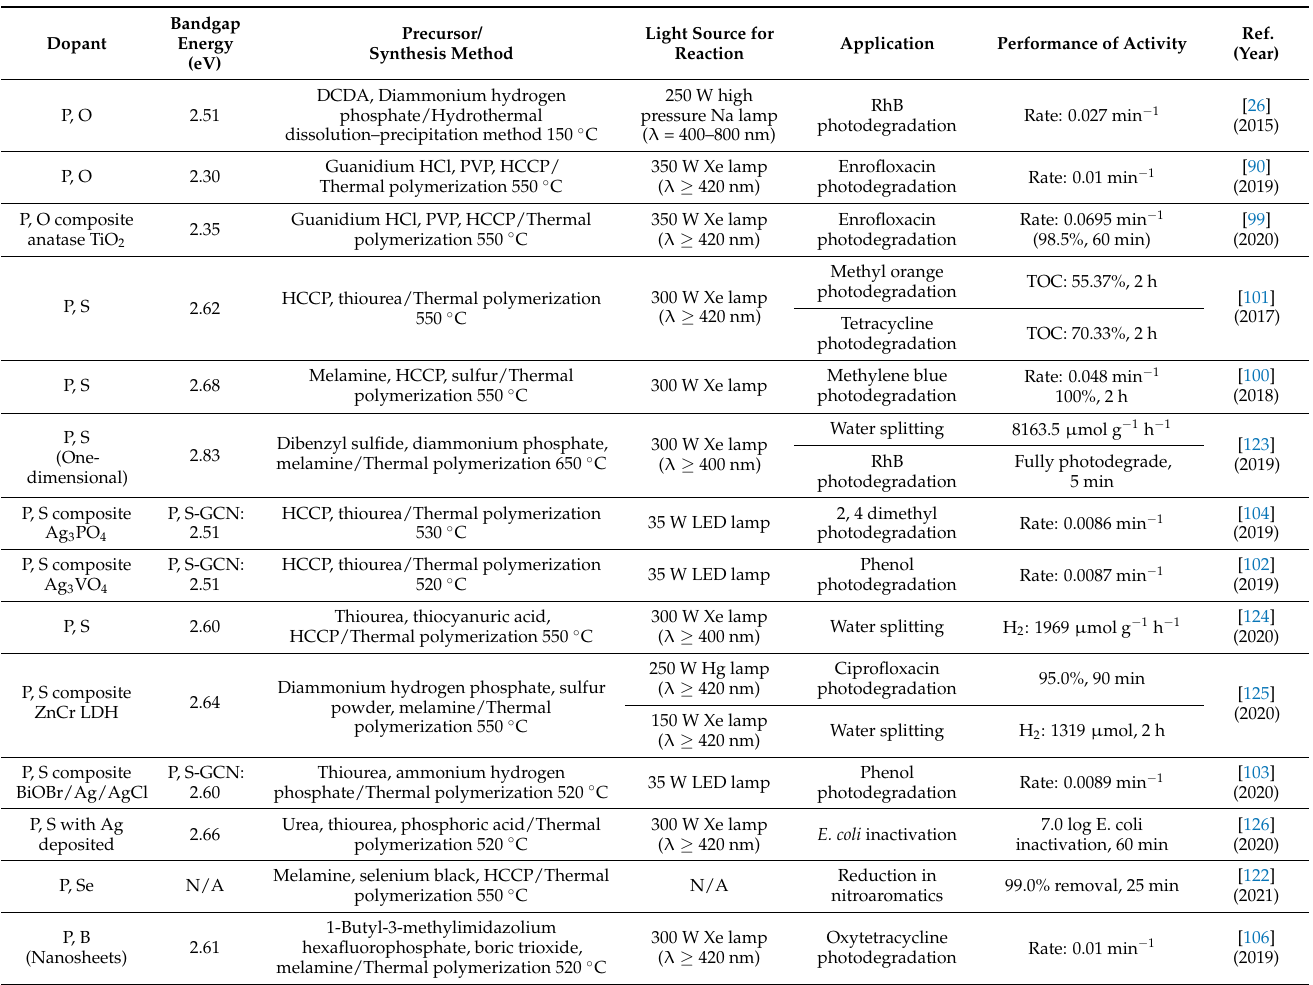
Table 2. The summary of non-metal-based co-doped